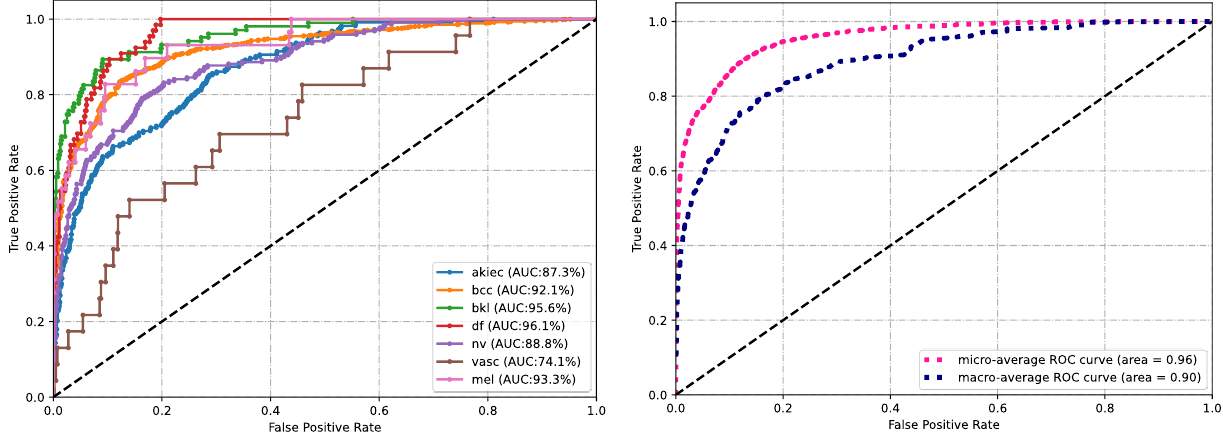
Figure 5. ( a – l ) Area under the receiver operating characteristic (ROC) curve (AUC) comparison between the proposed model for classification of the International Skin Imaging Collaboration (ISIC) 2018 dataset. The different classes (AKIEC = actinic keratosis; BCC = basal cell carcinoma; BKL = benign keratosis lesion; DF = dermatofibroma; MEL = melanoma; NV = melanocytic nevus; VASC = vascular lesion) are presented on the left and the mean on the